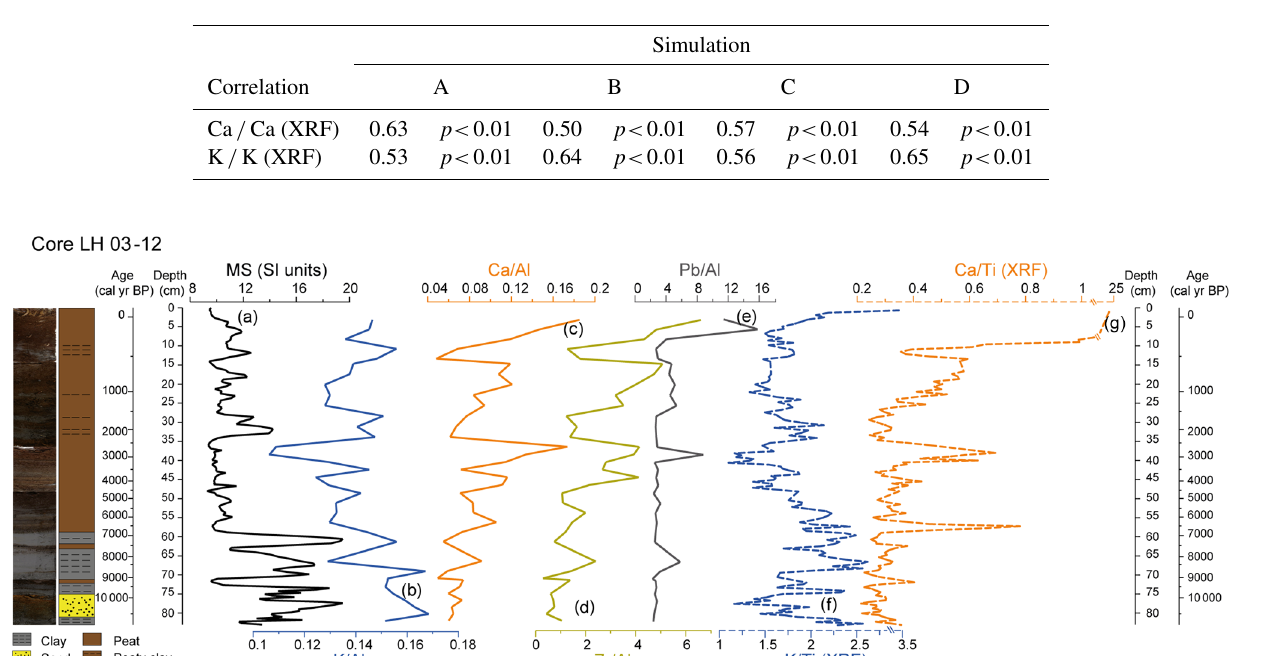
Table 2. Simulation of proxy correlation: (A) regular interpolation of 300 years sampling spacing, (B) regular interpolation of 300 years sampling spacing and five data points moving average, (C) regular interpolation of 150 years sampling spacing, (D) regular interpolation of 150 years sampling spacing and five data point moving average.